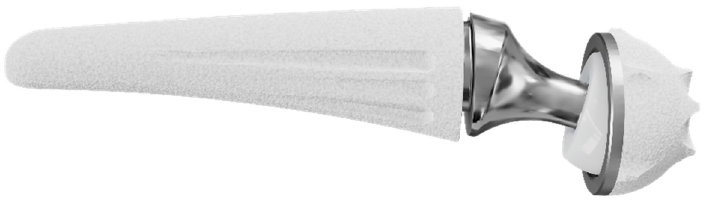
Figure 1. TOUCH ® dual mobility thumb CMC prosthesis (KeriMedical, Les Acacias, Switzerland).